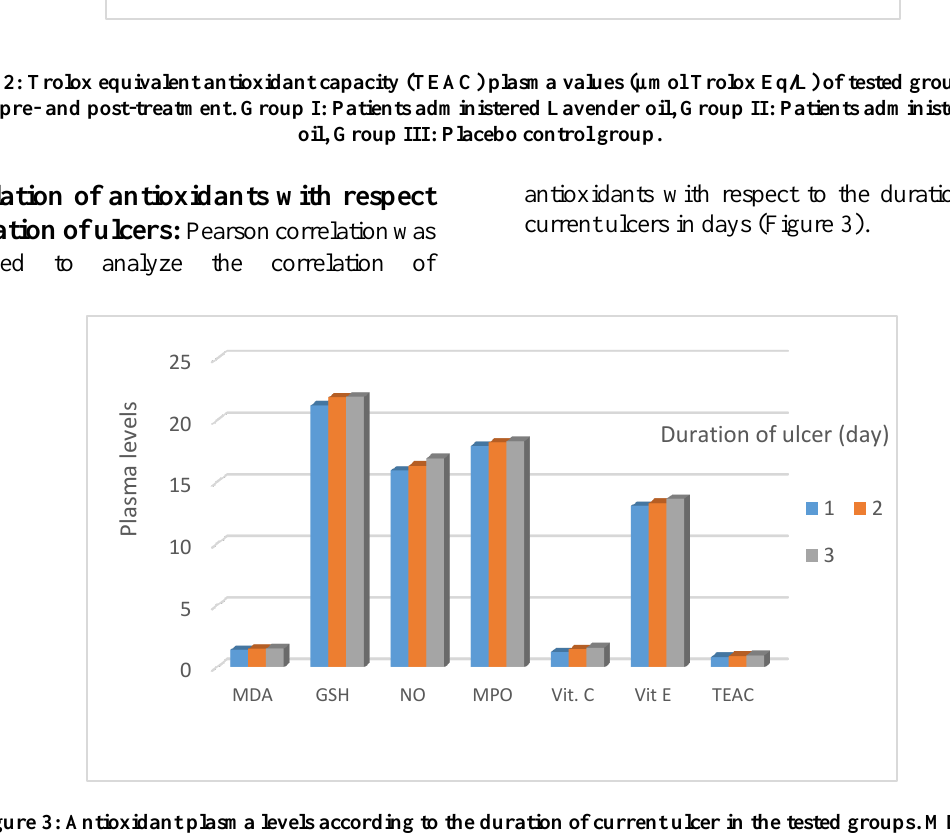
Figure 3: Antioxidant plasma levels according to the duration of current ulcer in the tested groups. MDA: malondialdehyde (µmol/L); GSH: glutathione (U/mg protein); NO: nitric oxide (µmol/L); MPO: myeloperoxidase (U/mg protein); Vit. E: vitamin E (μg/ml), Vit. C: vitamin C (μg/ml), TEAC: Trolox equivalent antioxidant capacity (µmol Trolox Eq/L). There was a positive correlation of antioxidant C, TEAC and the duration of current ulcer in the parameters MDA, GSH, NO, MPO, Vit. E, Vit. tested groups (Figure